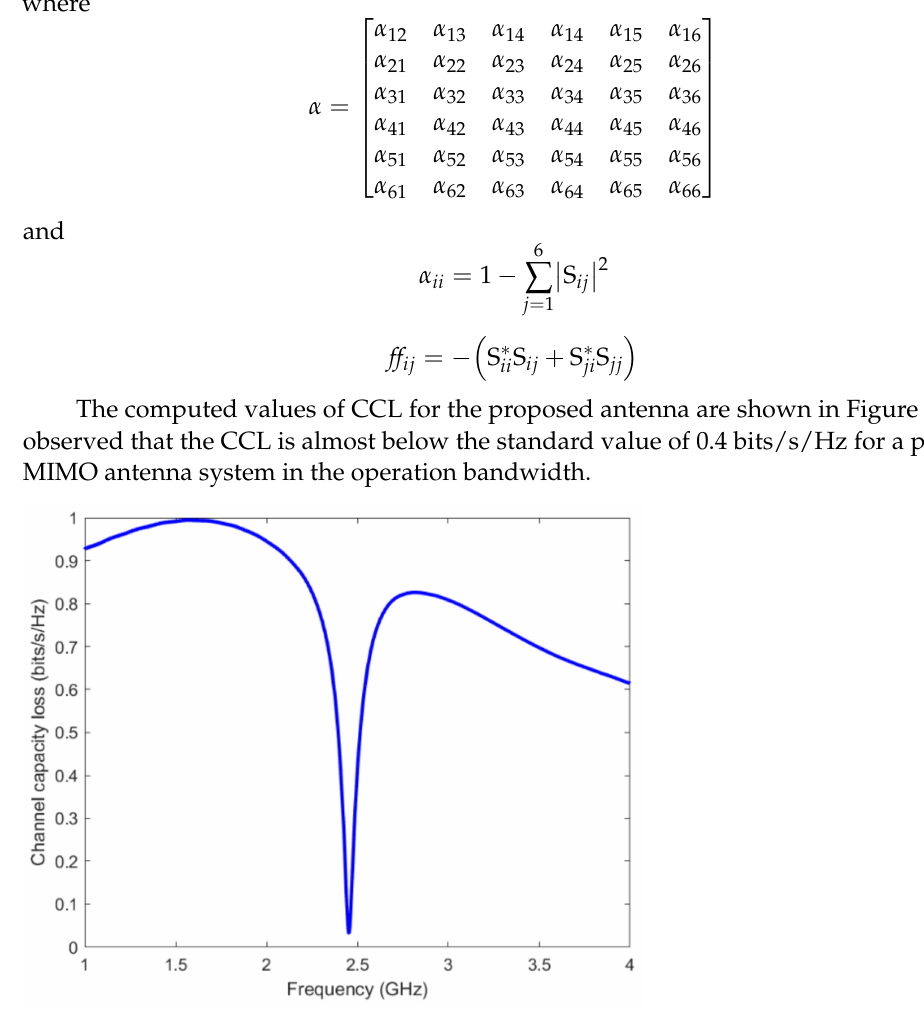
Figure 19. The CCL of the proposed MIMO